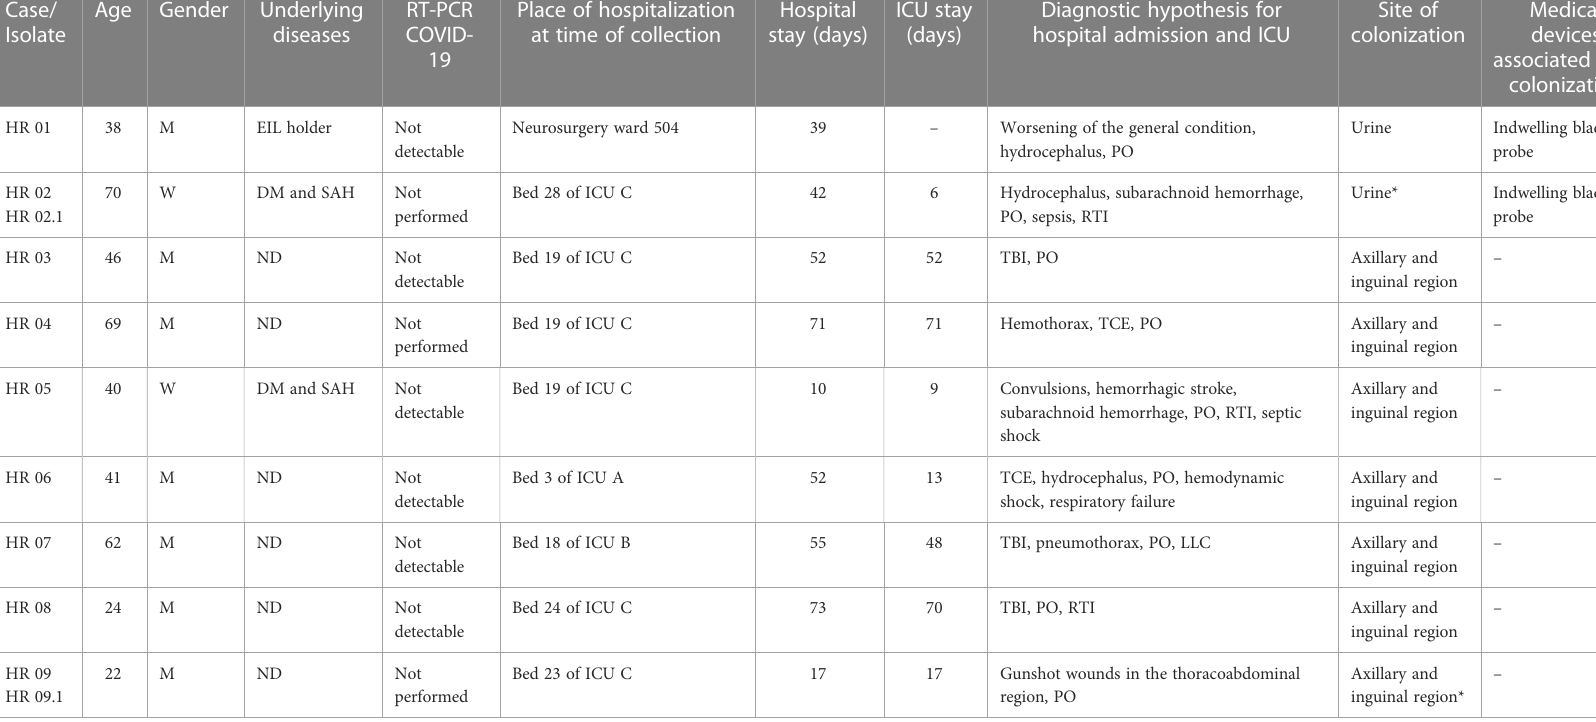
TABLE 1 Mapping of the clinical – epidemiological pro fi le of patients colonized by Candida auris . Case/